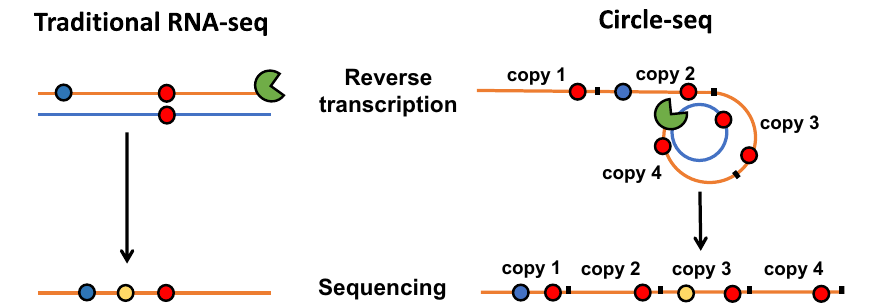
Fig. 1 | Core concept of the circle-sequencing assay. Traditional sequencing approaches can identify transcription errors (red circle) present in RNA molecules (blue lines). However, during reverse transcription of RNA templates, additional errors (blue circles) are introduced into the cDNA (yellow lines) by reverse tran- scriptases that are indistinguishable from true transcription errors. Additional artifacts (yellow circles) that resemble transcription errors are also introduced